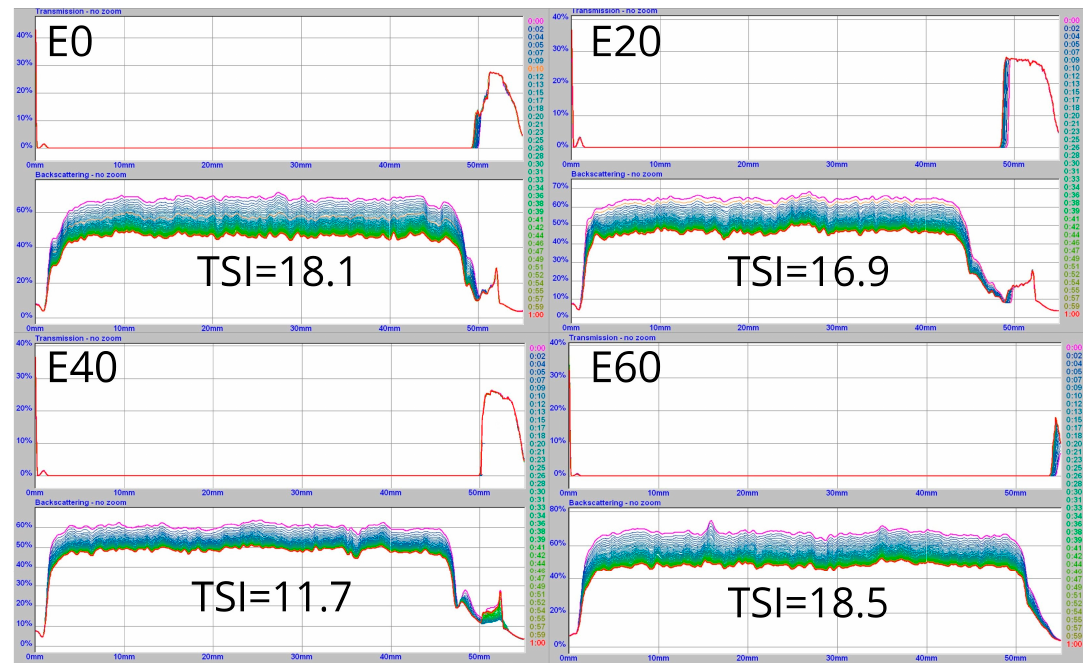
Figure 1. Transmission and backscattering and corresponding Turbiscan stability index (TSI) values of macaron ba tt ers before baking.